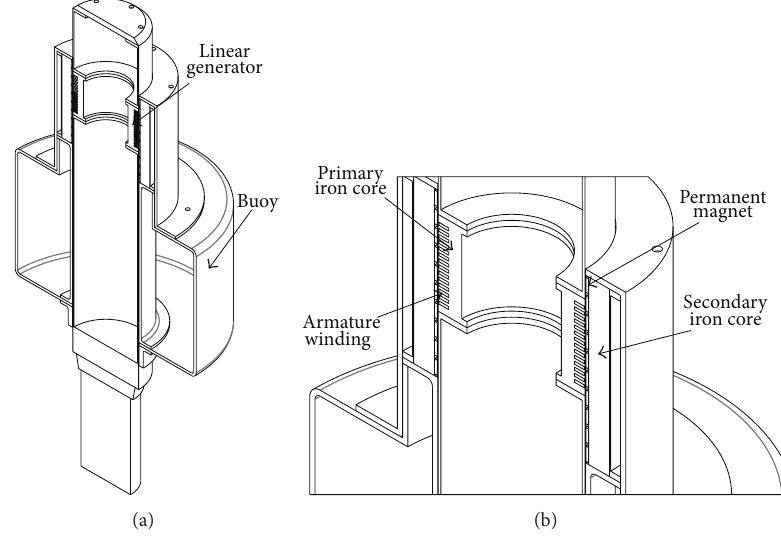
Figure 1: Structure of TPMLWG: (a) the whole structure of TPMLWG and (b) the structure of linear generator.